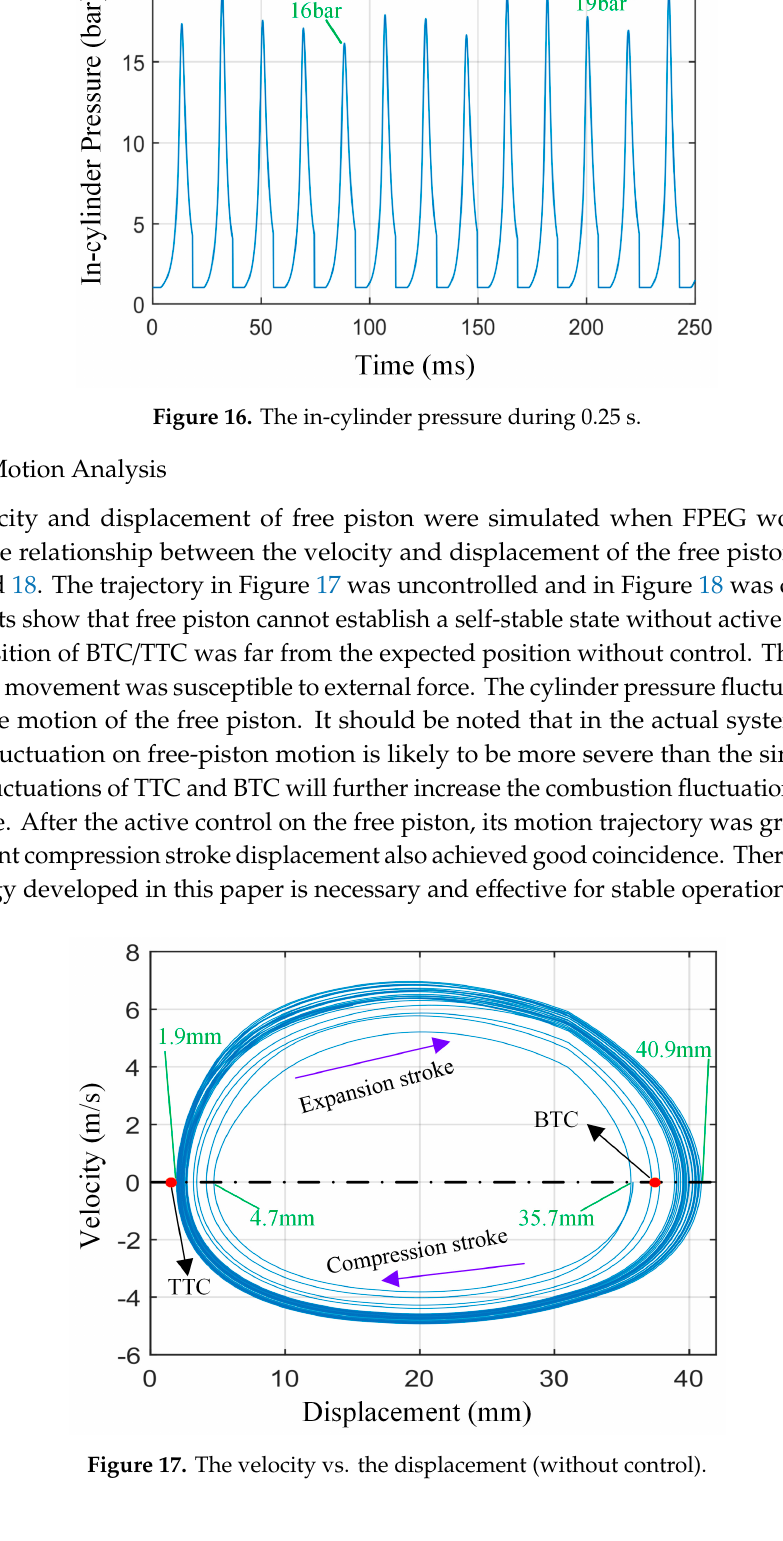
Figure 18. The velocity vs. the displacement (with control). The results show that free piston cannot establish a self-stable state without active motion control. The actual position of BTC/TTC was far from the expected position without control. This was because the free-piston movement was susceptible to external force. The cylinder pressure fluctuation interfered with the stable motion of the free piston. It should be noted that in the actual system, the effect of combustion fluctuation on free-piston motion is likely to be more severe than the simulation result because the fluctuations of TTC and BTC will further increase the combustion fluctuation, thus entering a vicious circle. After the active control on the free piston, its motion trajectory was greatly improved and the different compression stroke displacement also achieved good coincidence. Therefore, the active control strategy developed in this paper is necessary and effective for stable operation. 5.3.3. TTC and BTC Analysis The control objective was the TTC and BTC of free piston in this paper. The coordinates of each point in Figure 19 represent the cycle turning centers, and the Table 3 shows the statistical characteristics and target values of turning centers.